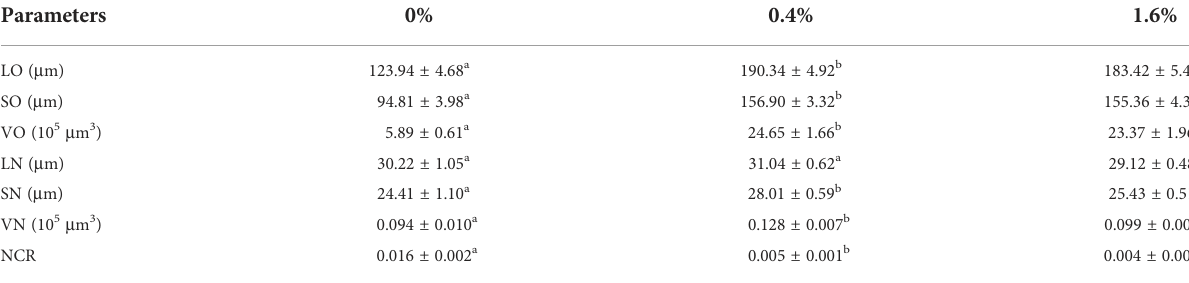
TABLE 3 Sizes of oocytes and nuclei in Eriocheir sinensis subjected to different levels of dietary CHO.